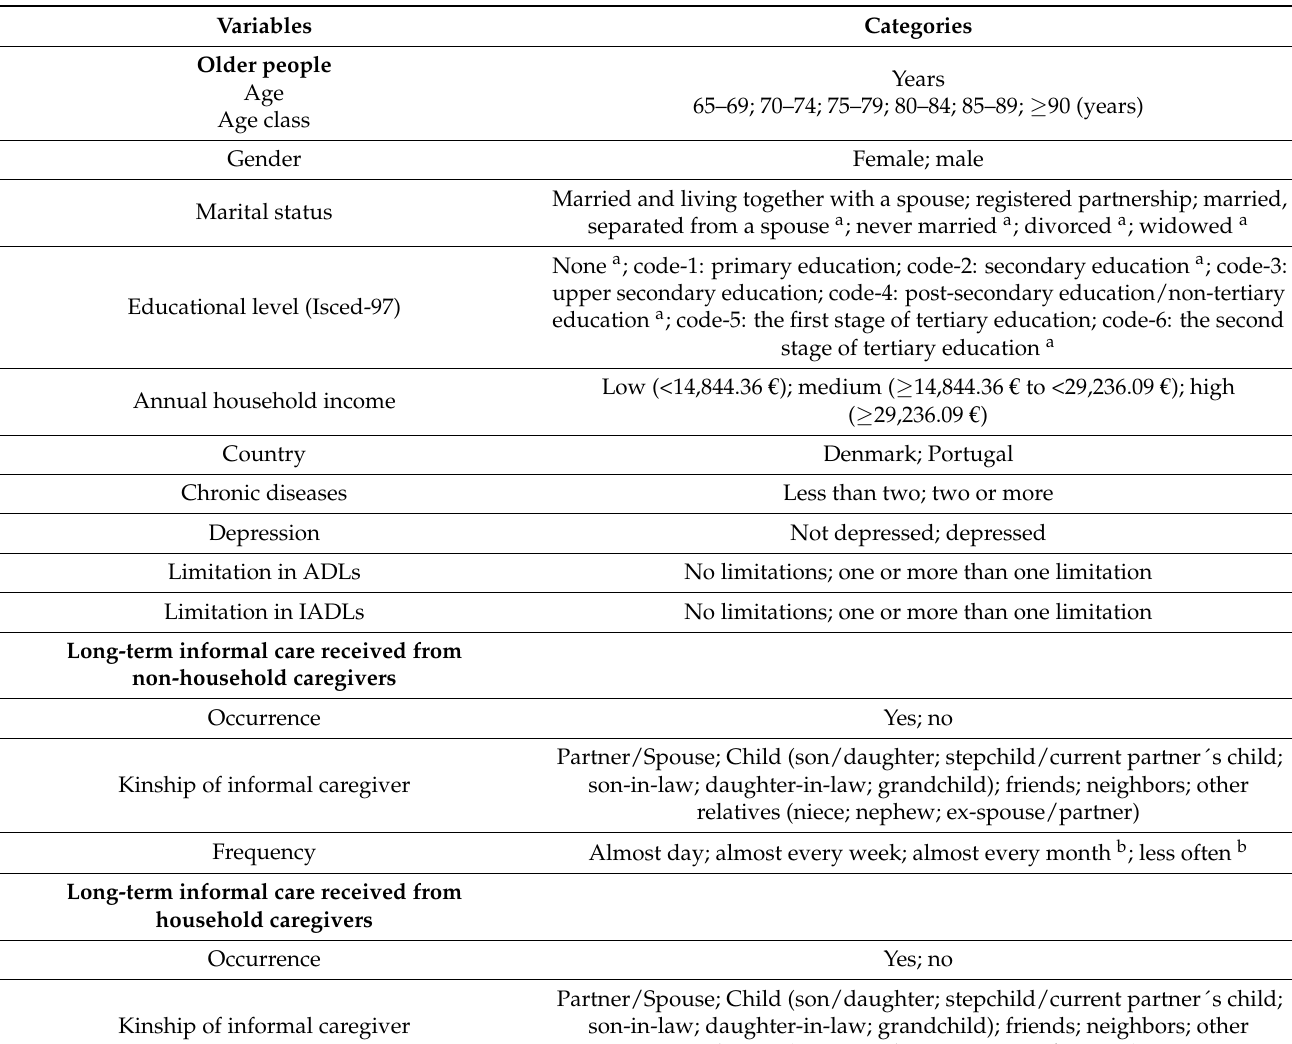
Table 1. Variables to characterize older people and long-term informal